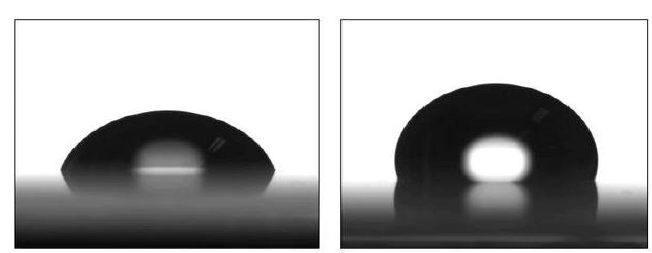
Figure 1. The profile of a water drop on the MIP film with macro-CTAs ( left ) and without CTAs ( right ).